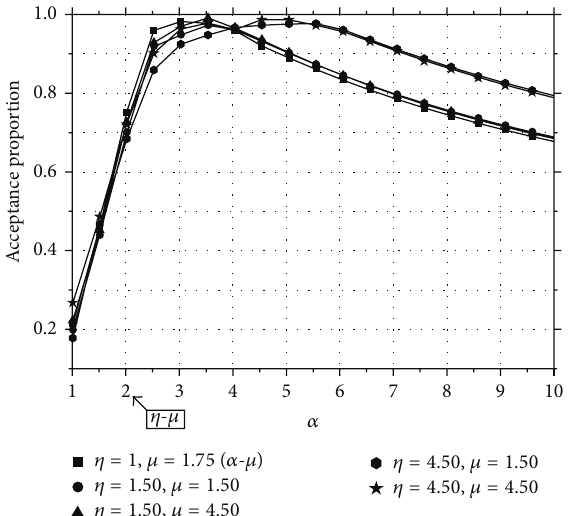
𝛼 = 2.25 , 𝜅 = 3.75 , 𝜇 = 2.50 𝛼 = 2.25 , 𝜅 = 3.50 , 𝜇 = 1.75 𝛼 = 1.50 , 𝜂 = 3.25 , 𝜇 = 1.50 𝛼 = 1.50 , 𝜂 = 2.75 , 𝜇 = Figure 1: Simulated and theoretical 𝛼 - 𝜅 - 𝜇 and 𝛼 - 𝜂 - 𝜇 densities.